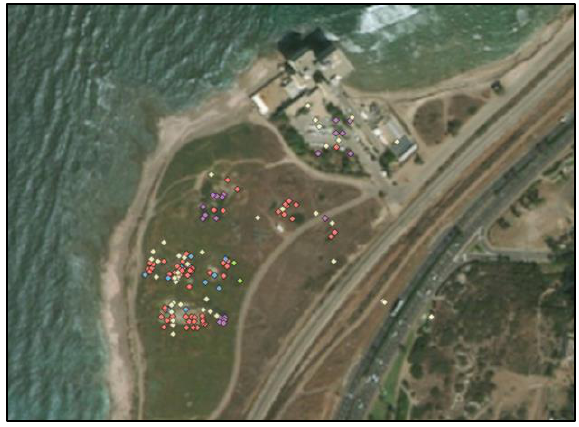
Figure 6. level of risks to mosaics in Tel Shiqmona.